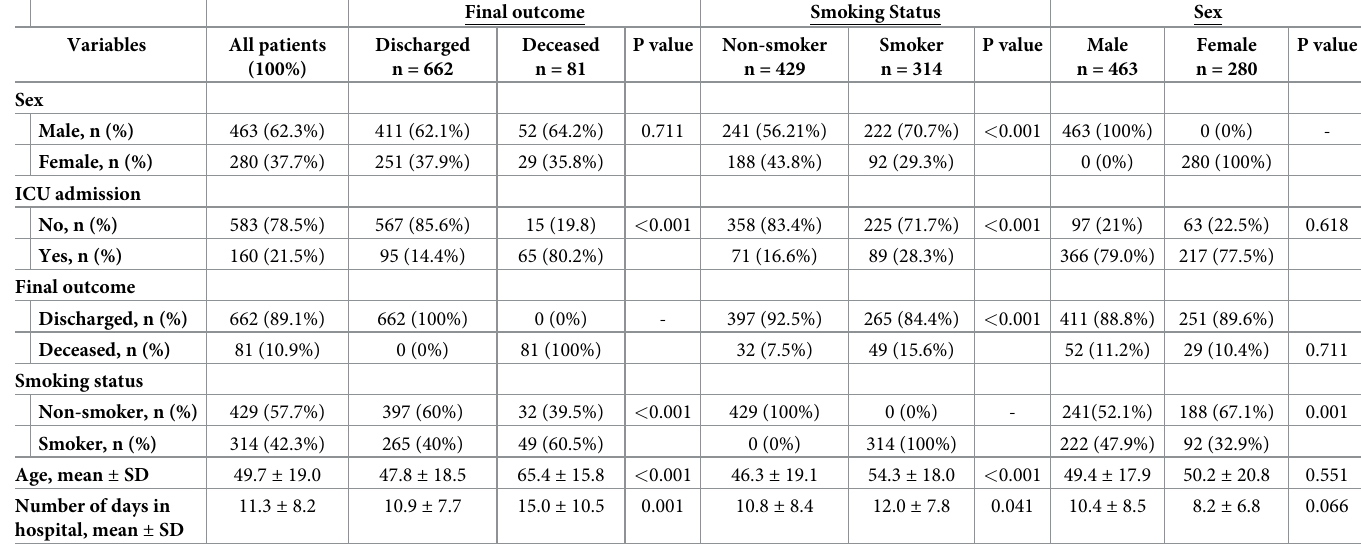
Table 1. Characteristics of the hospitalized COVID-19 patients (n = 743) according to their final outcome, smoking status, and sex. SD = standard deviation. Final outcome Smoking Status